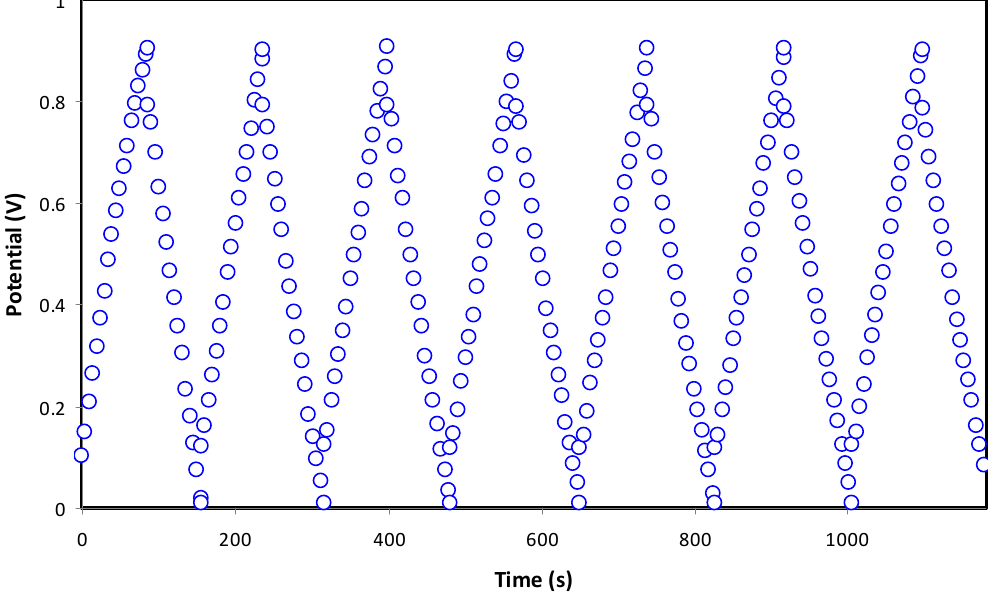
Figure 8. Charge–discharge pattern of the fabricated electric double layer capacitor (EDLC) at specific cycles.